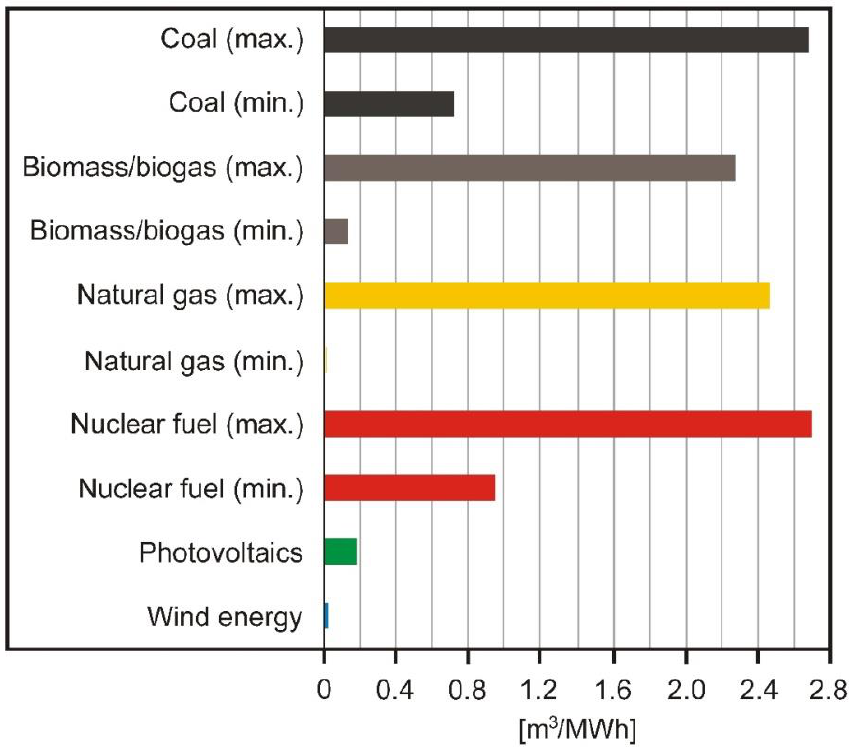
Figure 3. Water consumption with different methods of energy production in the world [12].